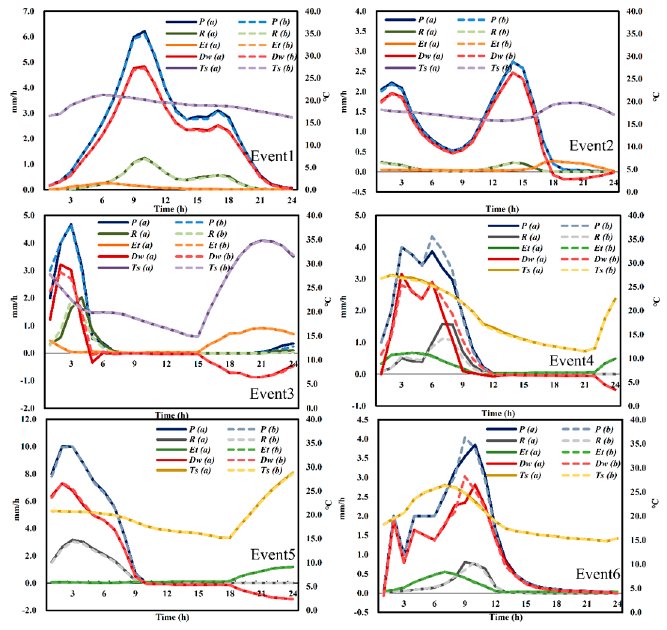
Figure 10. Temporal variations of the grid average values for the crucial elements in the water cycle: ( a ) WRF-only; ( b ) the fully coupled WRF/WRF-Hydro.